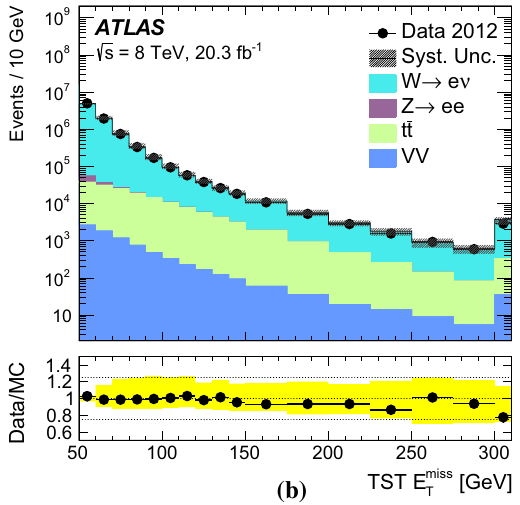
Fig. 6 Distributions of the a CST and b TST E miss data sample of W → e ν events. The lower panel of the figures show the ratio of data to MC simulation, and the bands correspond to the